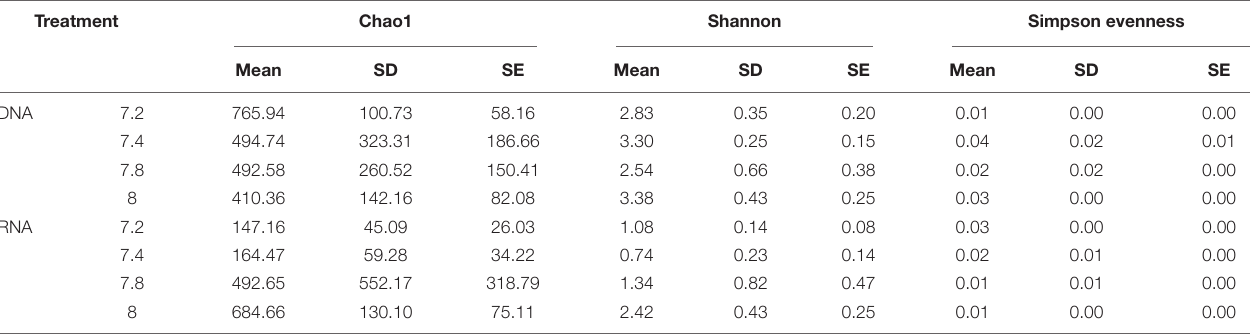
TABLE 1 | Differences in alpha diversity indices (Chao estimate of species richness, Shannon and Simpson evenness) in microbiome of Stylophora pistillata kept in aquaria for 2 years at different pH treatments (7.2; 7.4, 6.8 and 8.0) for DNA and RNA samples. Treatment Chao1 Shannon